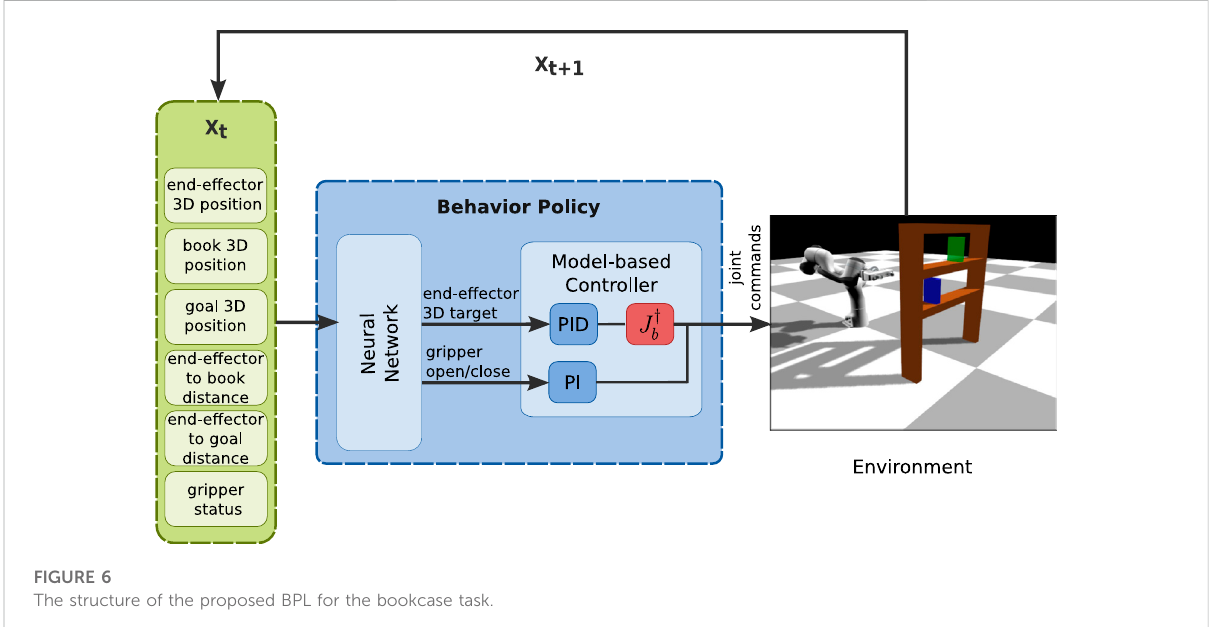
FIGURE 6 The structure of the proposed BPL for the bookcase task.